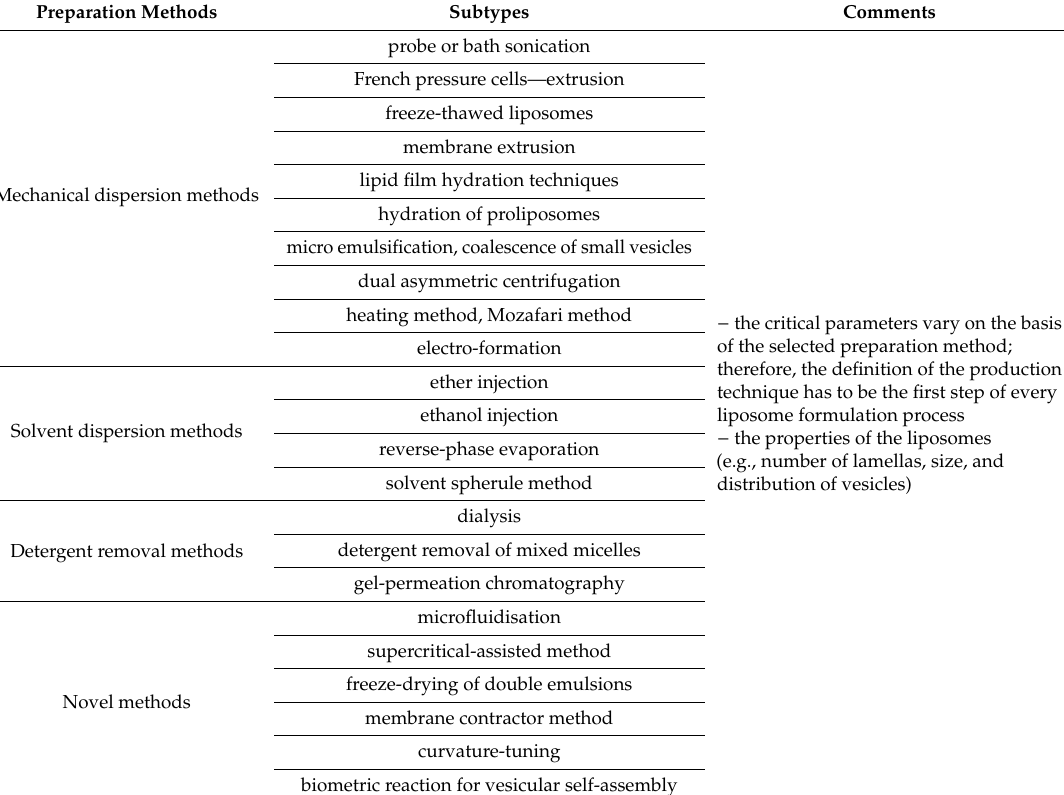
Table 1. Potential methods to prepare liposomes.